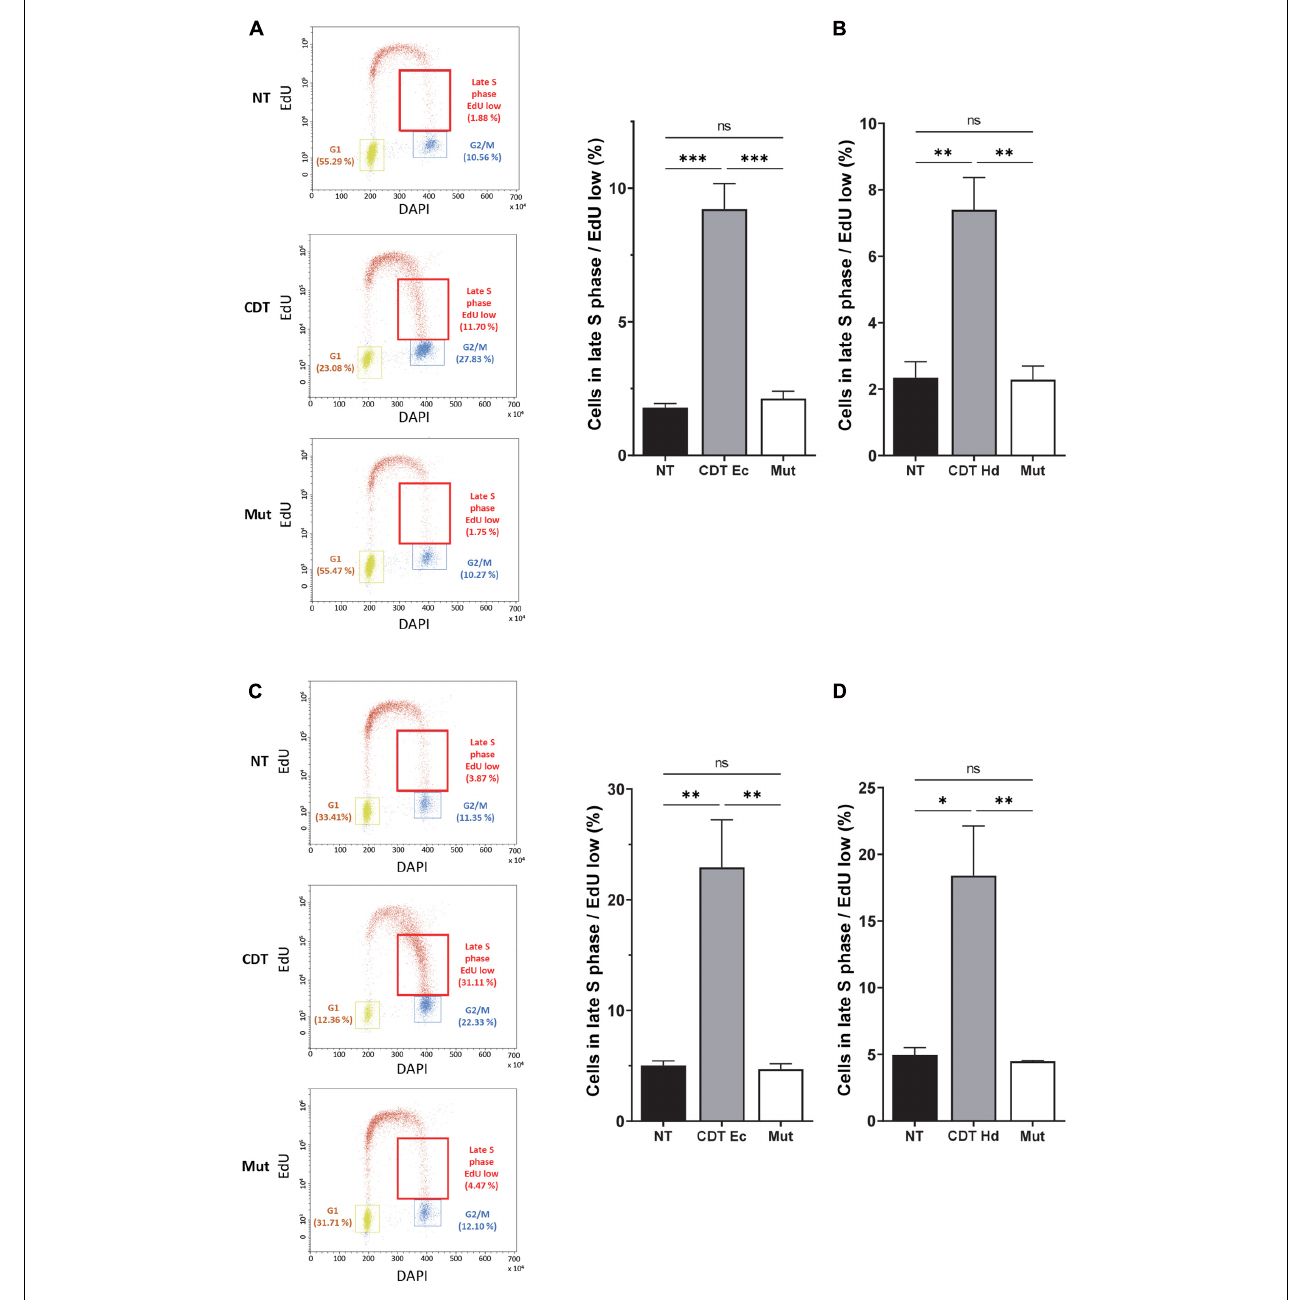
FIGURE 2 | CDT causes a slowdown of DNA replication in the late S phase. Cell cycle analysis by flow cytometry of HeLa (A,B) and U2OS (C,D) cells treated or not with 2.5 ng/ml of wild-type or catalytically inactive CDT mutant (Mut) from E. coli (CDT Ec) (A,C) or H. ducreyi (CDT Hd) (B,D) for 16 h was performed. (A,C) Left panel: representative flow cytometry of cells treated with CDT Ec is shown. EdU incorporation is plotted against the cellular DNA content (DAPI). Quantification of G1, G2, and late S cell population with low EdU (red boxes) is indicated. Right panel: data represent the percentage of EdU weakly positive cells in the late S phase. At least 10,000 events were analyzed per sample using the CytExpert software (mean ± SEM of at least three independent experiments) ( ∗ P < 0.05, ∗∗ P < 0.01, ∗∗∗ P < 0.001, and ns, not